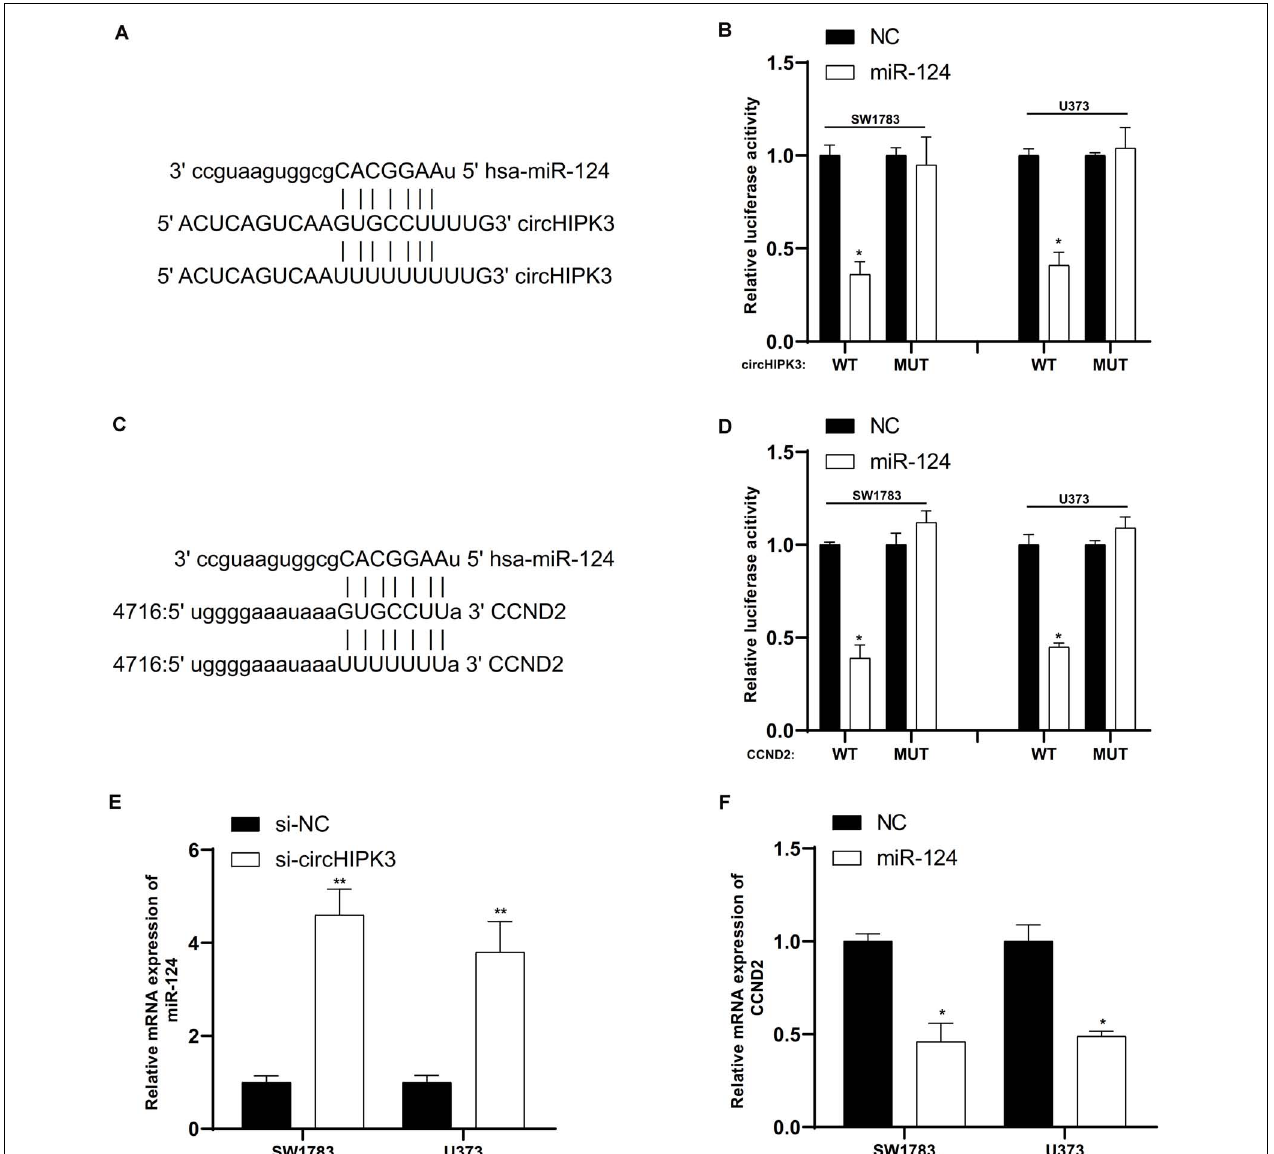
FIGURE 6 | CircHIPK3 affected CCND2 expression by directly targeting miR-124. (A) CircHIPK3 had a potential role to sponge miR-124. (B) MiR-124 up-regulation markedly suppressed the luciferase activity when co-transfected miR-124 with circHIPK3 wild-type vectors. (C) CCND2 was a potential target of miR-124. (D) MiR-124 overexpression markedly suppressed the luciferase activity when co-transfected miR-124 with CCND2 wild-type vectors. (E) MiR-124 RNA levels were induced after knockdown of circHIPK3. (F) MiR-124 overexpression repressed the expression of CCND2. ∗ p < 0.05, ∗∗ p < 0.01.